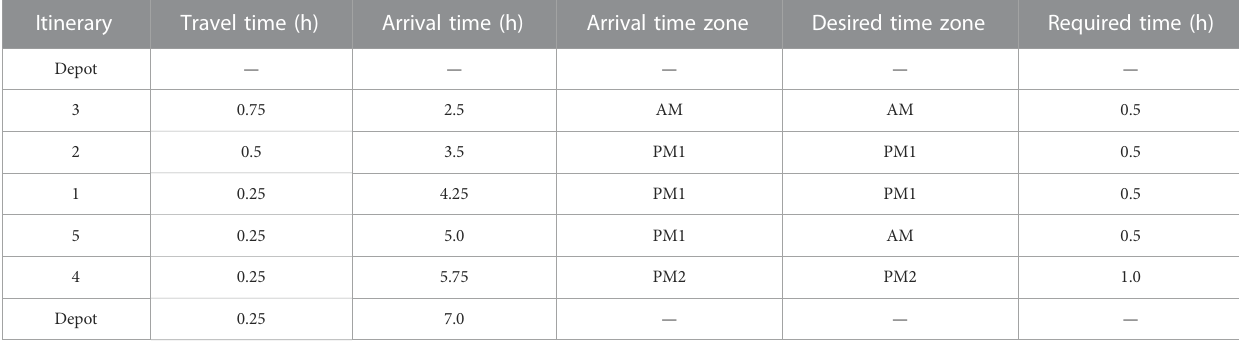
TABLE 5 Example of break solutions for route optimization results at instance No. 9 in the base case. The meaning of the “ Itinerary ” column is the same as in Table 4. A fourth visit breaks the desired time constraint. Itinerary